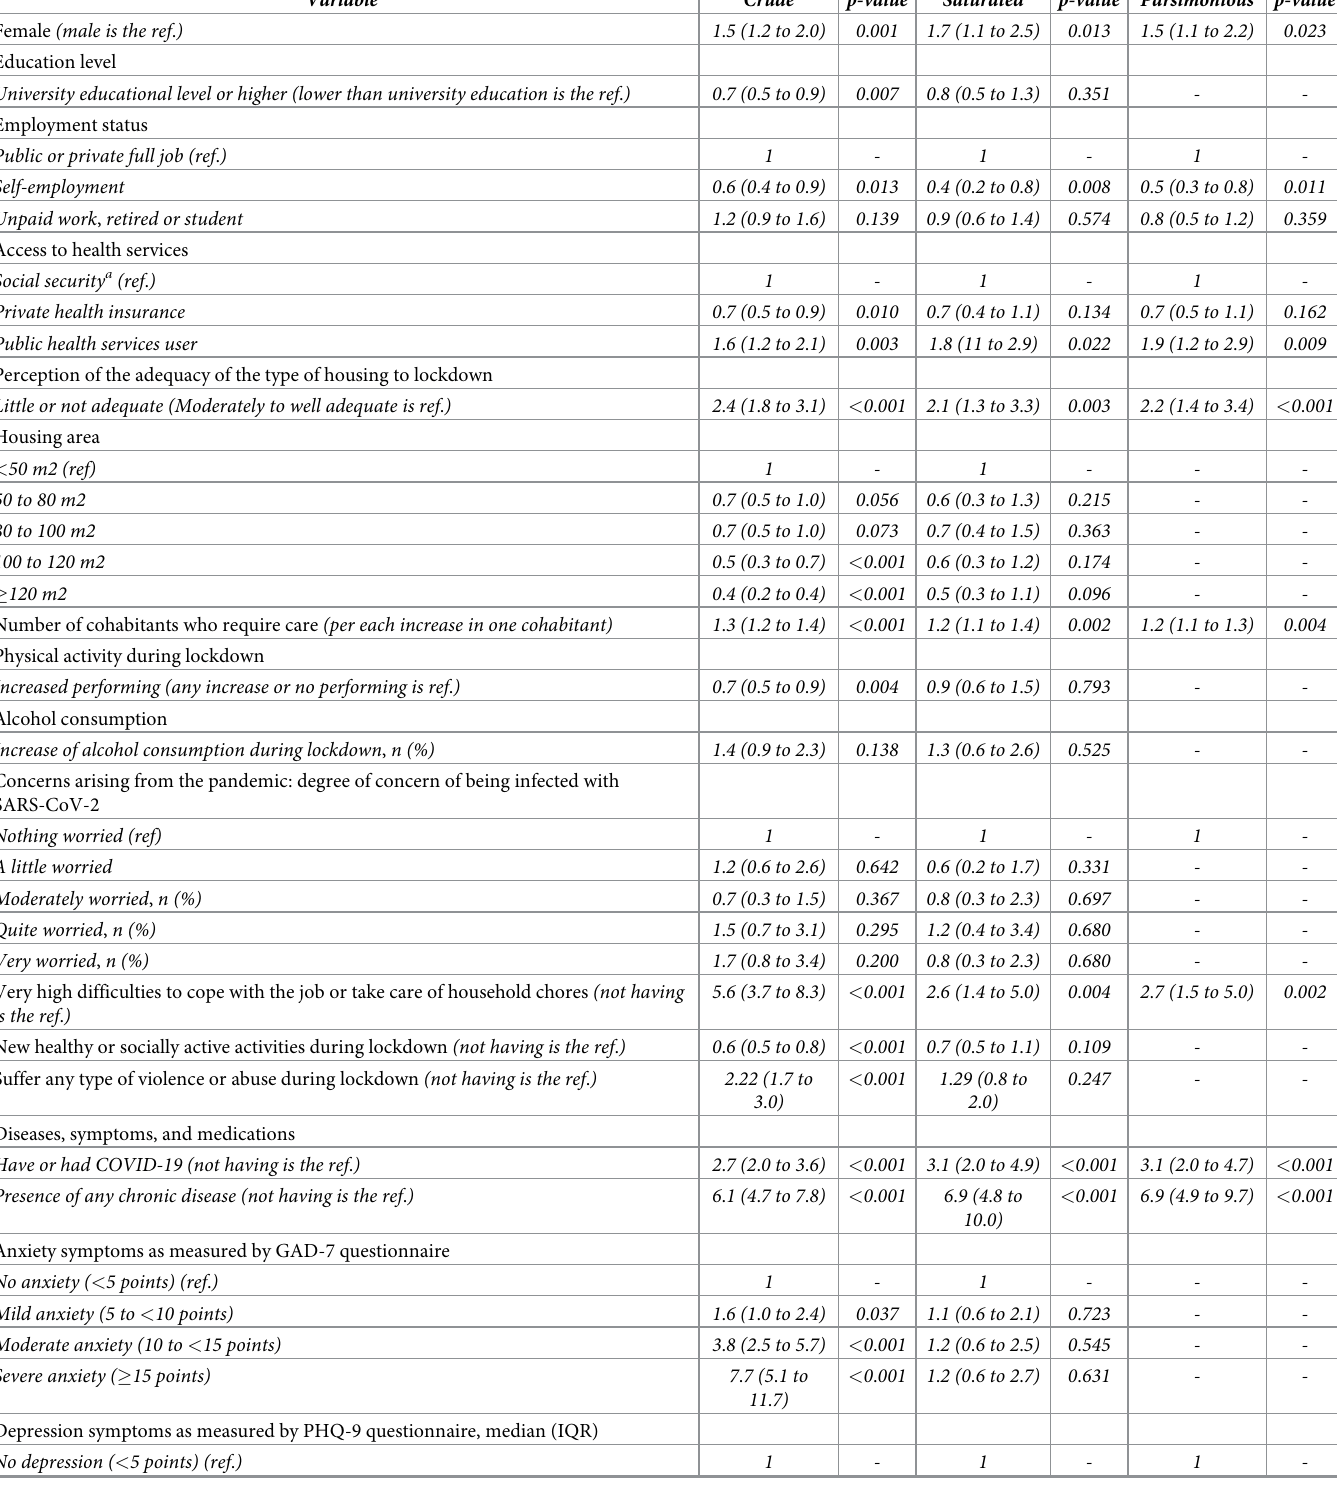
Table 4. Crude and adjusted odds ratios of regular or bad health